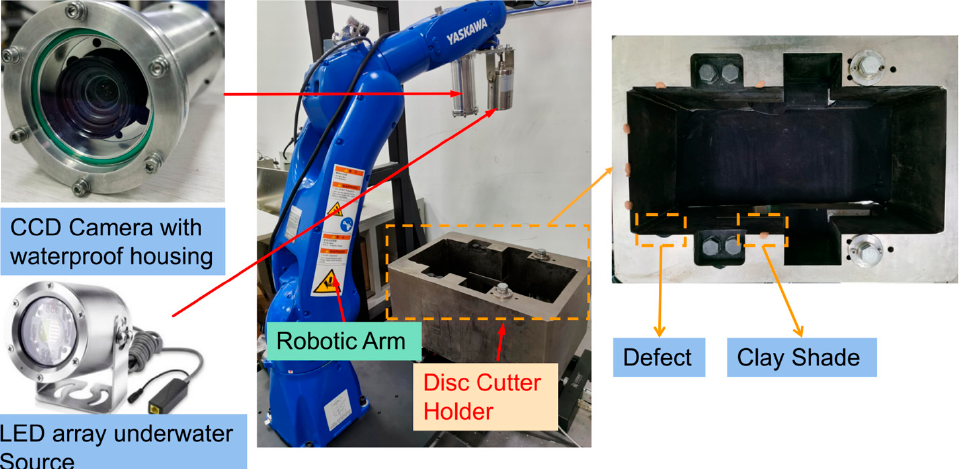
Figure 2. The hardware framework of the pose-estimation module in the lab.